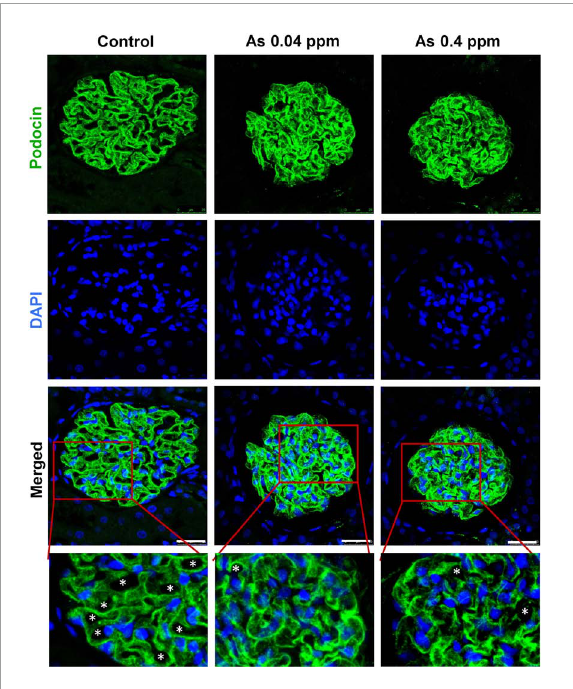
FIGURE6 Prenatal As exposure induced ultrastructural changes in the glomerulus are reflected in the abnormal expression pattern of podocin (NPHS2). IHC images of the glomerular region showing staining for podocin and DAPI. The expression of podocin is continuous in the control kidney sections, while it is diffused and discontinuous in As exposed offspring. Inset views of corresponding images clearly show the pattern of podocin expression in the control and treated section. Asterisk represents open tubules which are reduced in As exposed animals. Bar = 25 µ